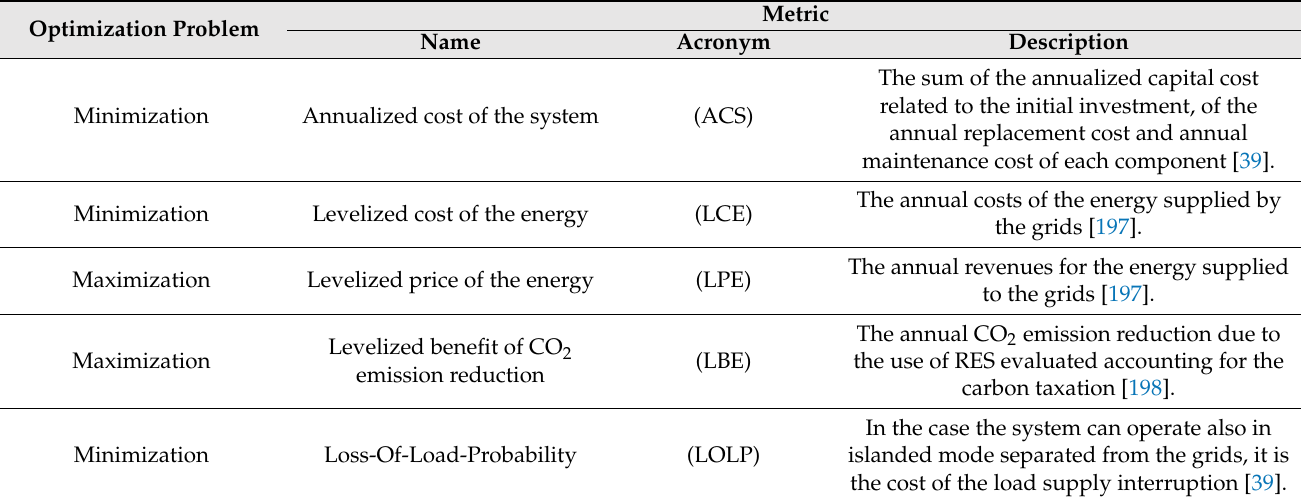
Table 4. Typical metrics used for optimal design